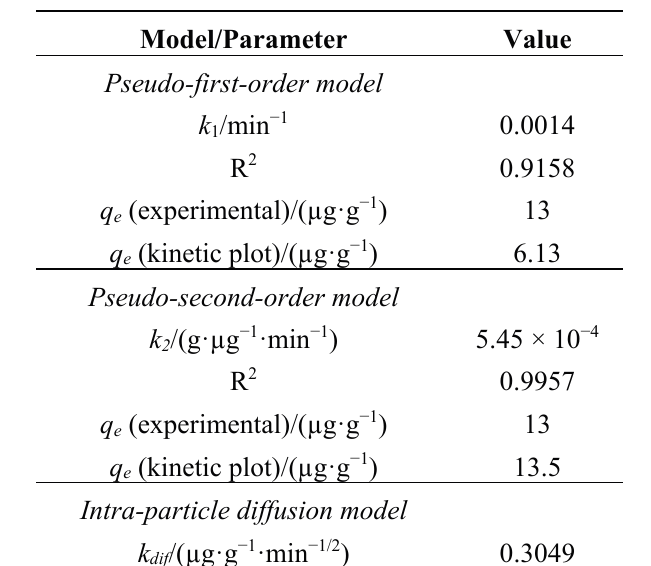
Table 1. Kinetic parameters for As(V) adsorption onto Fe-XAD8-DEHPA